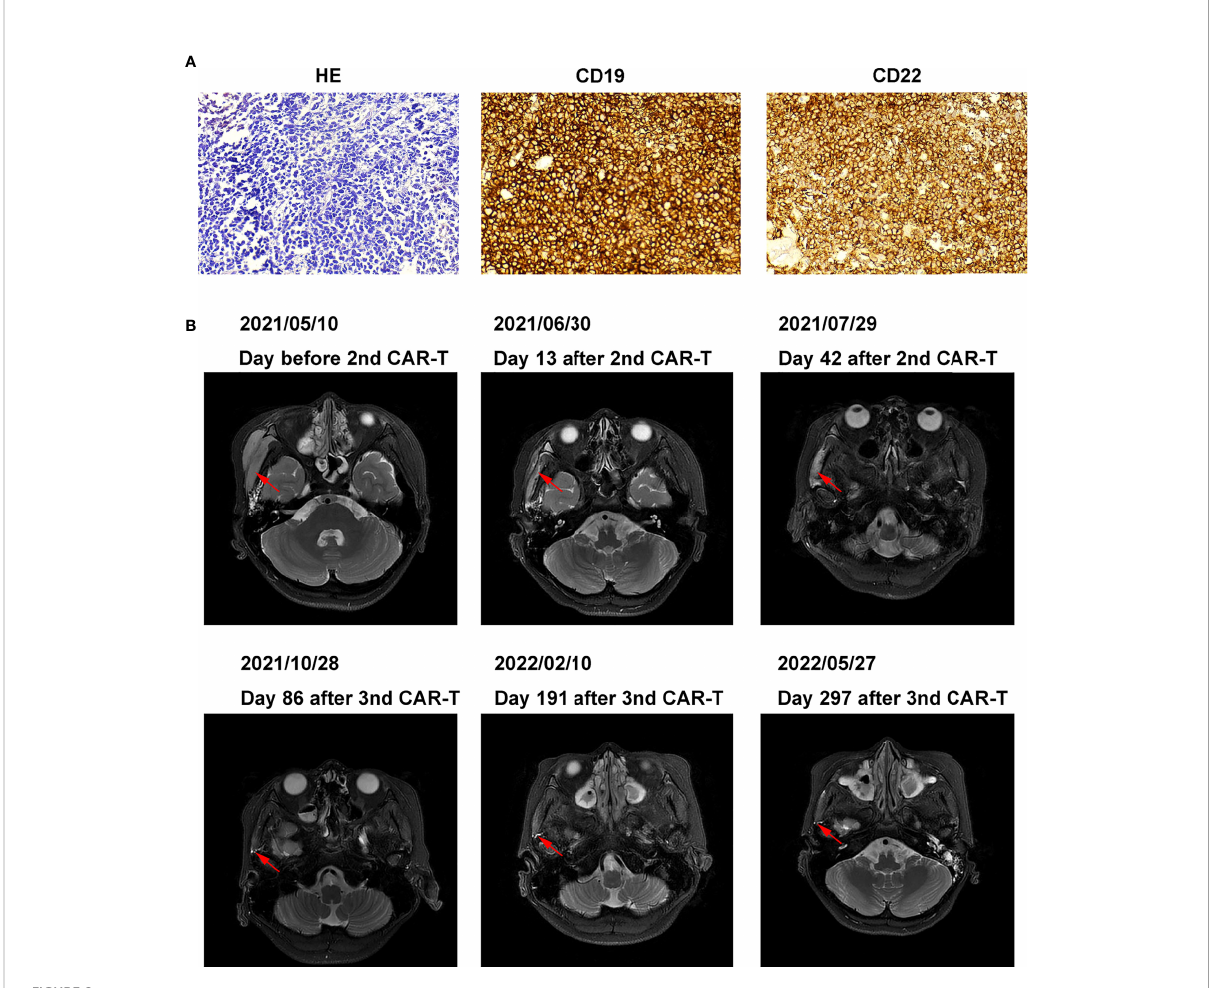
FIGURE 2 Pathology, histochemistry, and MRI images of right facial mass (A) Pathology and histochemistry of right facial mass. (B) MRI images of the right facial mass before and after 2nd, the 3rd CAR-T cell